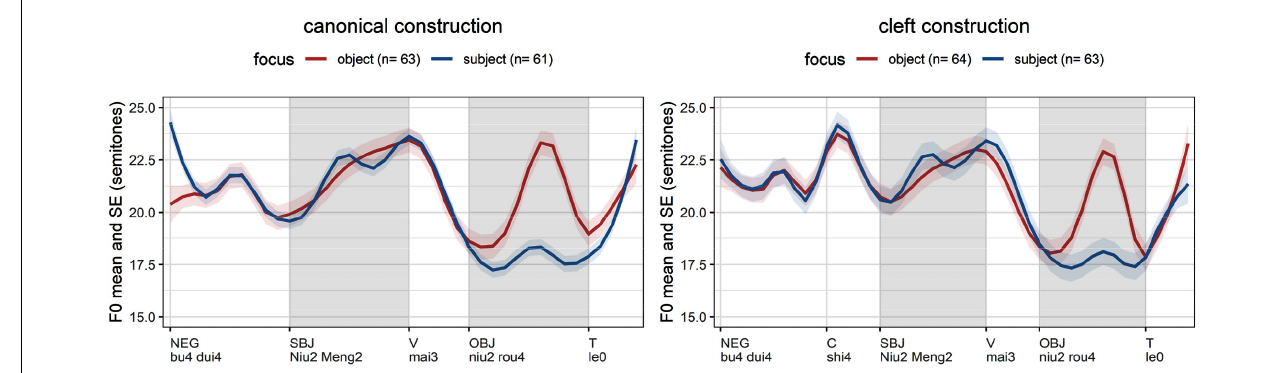
FIGURE 6 | Average f o measurements in Chinese (time normalization based on five equal intervals per syllable; vertical lines: word edges; gray cells: areas of interest, subject and object). TABLE 1 | Linear fixed-effects models of best fit on the f o measurements (semitones): subject.